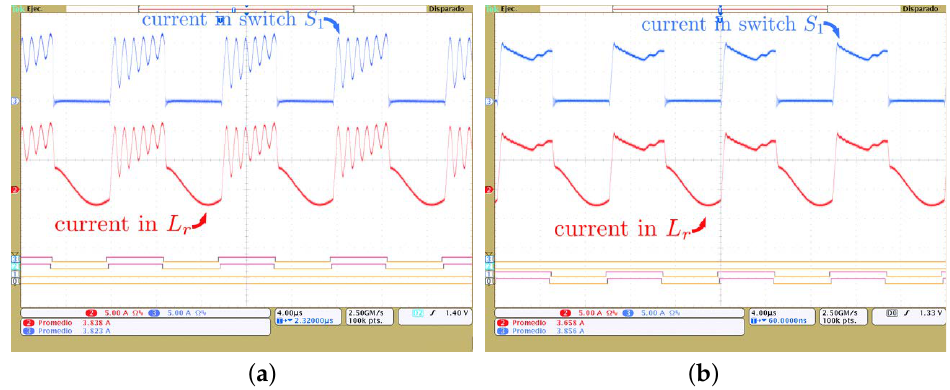
Figure 13. Current in L r and current in main switch S 1 : ( a ) Ccurves for the real ACF; ( b ) curves for the EACF. The value for the resonant inductor was L r = 1µH in both